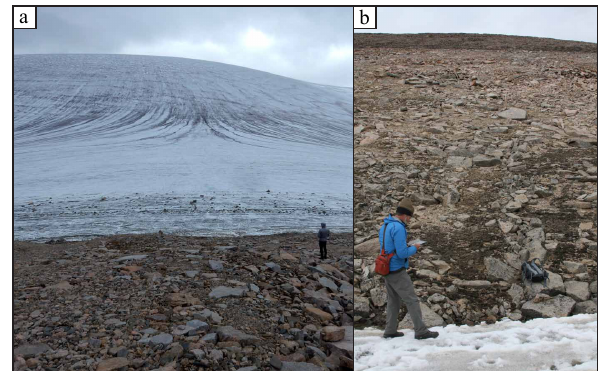
Figure 2. (a) View south towards north aspect of DIC, with supraglacial channels demarcating the modern topographic divide. (b) View north along transect up towards the maximum Neoglacial DIC extent; note large mats of dead vegetation diminish away from current ice